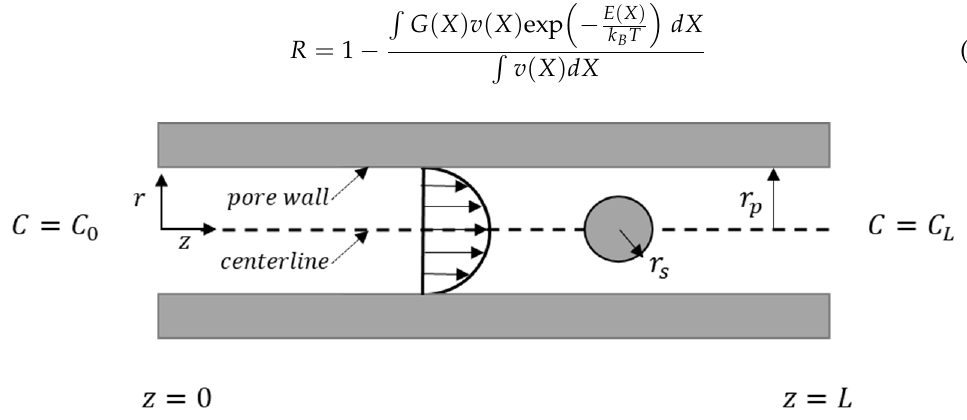
Figure 1. Schematic 2D diagram of a rigid spherical particle in a cylindrical pore. Here, X ( x , y ) is the two-dimensional position vector in the pore, E ( X ) is the particle– pore wall interaction energy, G ( X ) is the local lag coefficient, which characterizes the hydrodynamic interactions (defined as the velocity of the particle at position X , relative to the fluid velocity at X if the particle was not present), v ( X ) is the solution velocity in the pore, k B is the Boltzmann constant, and T is temperature. The hydrodynamic interactions are altered by any force that impacts the particle’s position in the pore. Even if long-range forces (e.g., van der Waals or electrostatic forces) are insignificant, the solute’s finite size limits its access to the region near the wall, affecting its flow [13]. Equation (2) assumes solute–solute interactions are